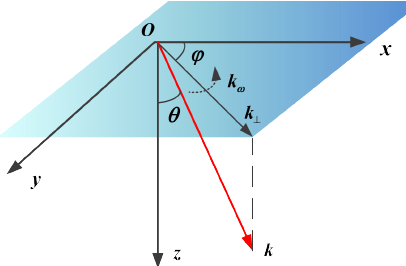
Figure 8. The propagation coordinate system of sliding spotlight SAR